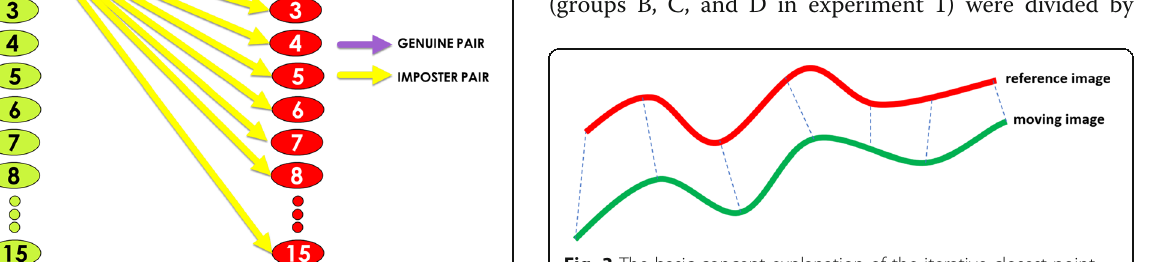
Fig. 3 The basic concept explanation of the iterative closest point (ICP)